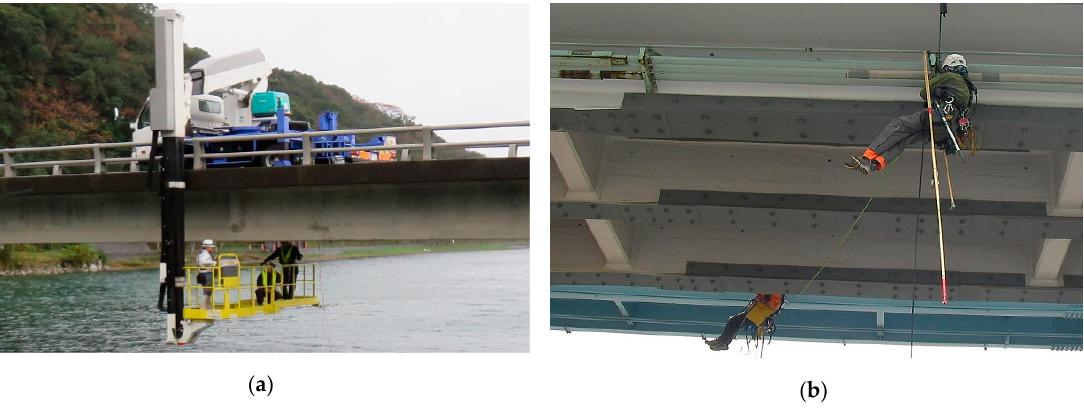
Figure 1. Example of inspection using a high-location work vehicle ( a ) and rope access ( b ).